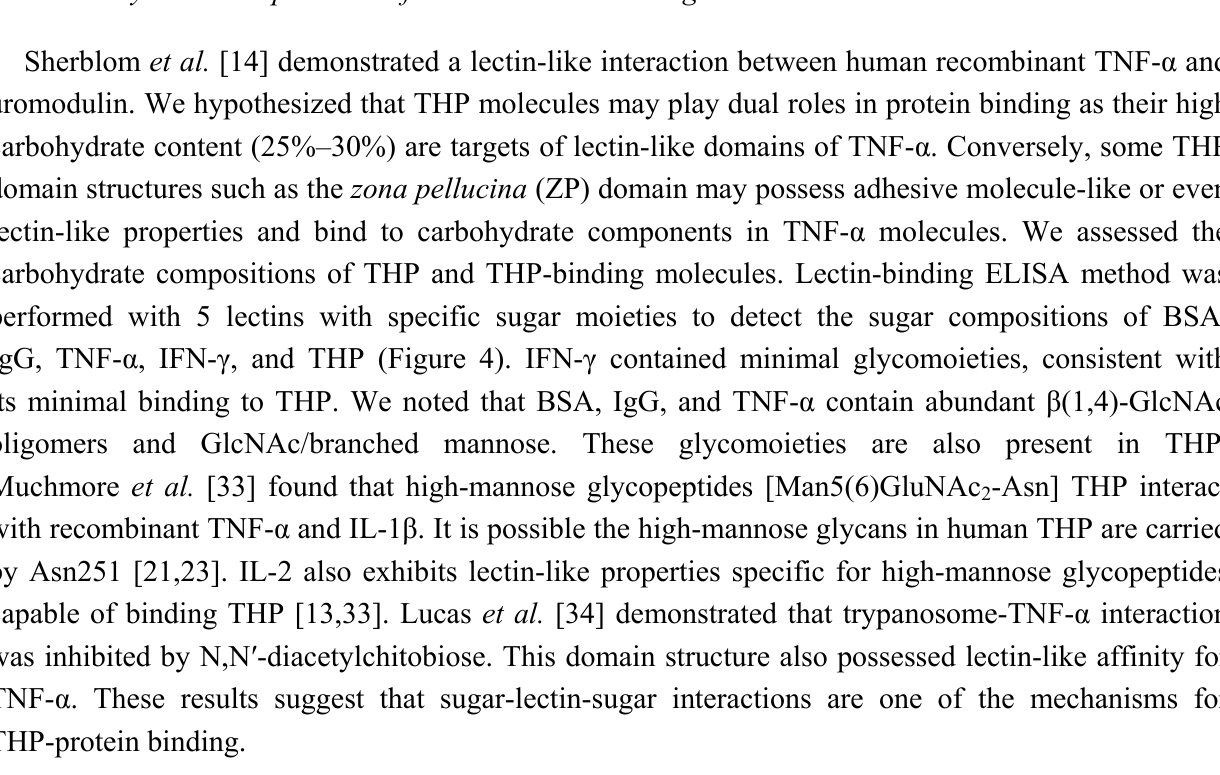
Figure 4. Carbohydrate compositions of BSA, human IgG, human recombinant TNF- α , human recombinant IFN- γ , and human urinary THP were dissected by lectin-binding assay using 5 lectins with different sugar-binding